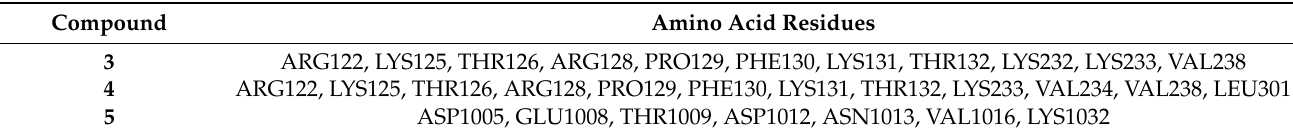
Figure 2. The molecular docking model of interaction of compounds 3–5 with P2Y 12 . The blue, dashed lines show the formation and distance of the H-bonds. Table 2. Amino acid residues of P2Y 12 binding sites.